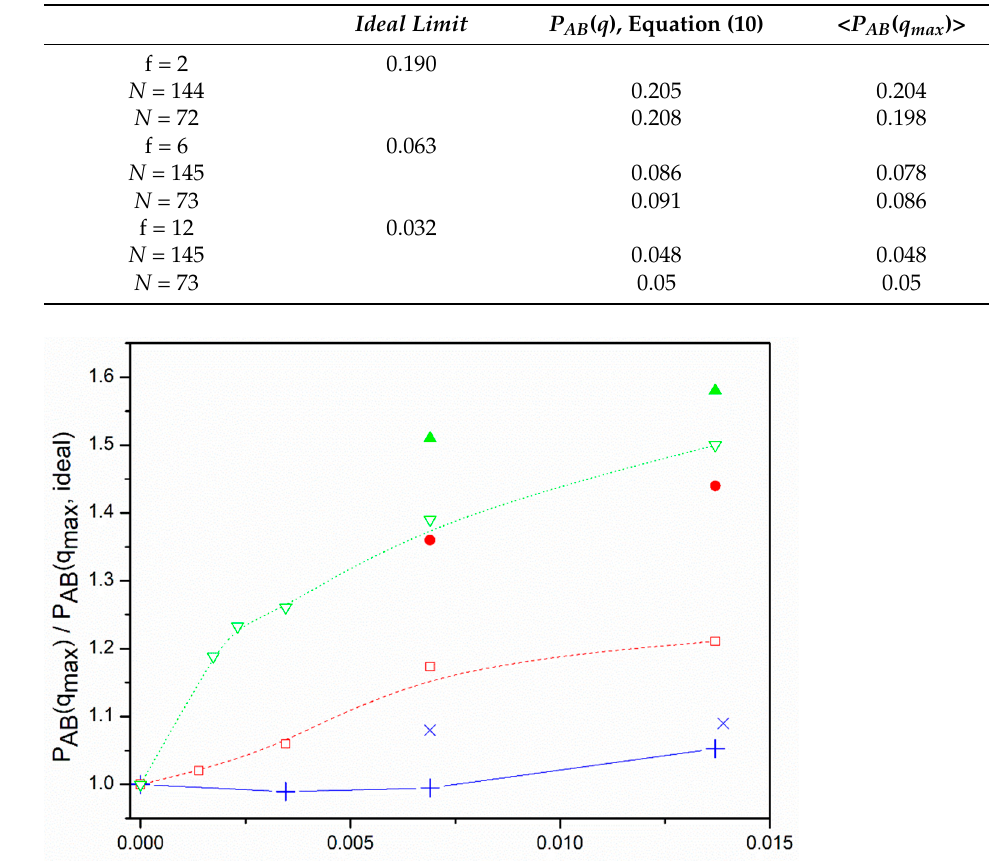
Table 2. Values of the form factor according to the RPA and simulation results obtained from the two different models explained in the text for the systems with the highest density, Φ ∼ = 0.275.